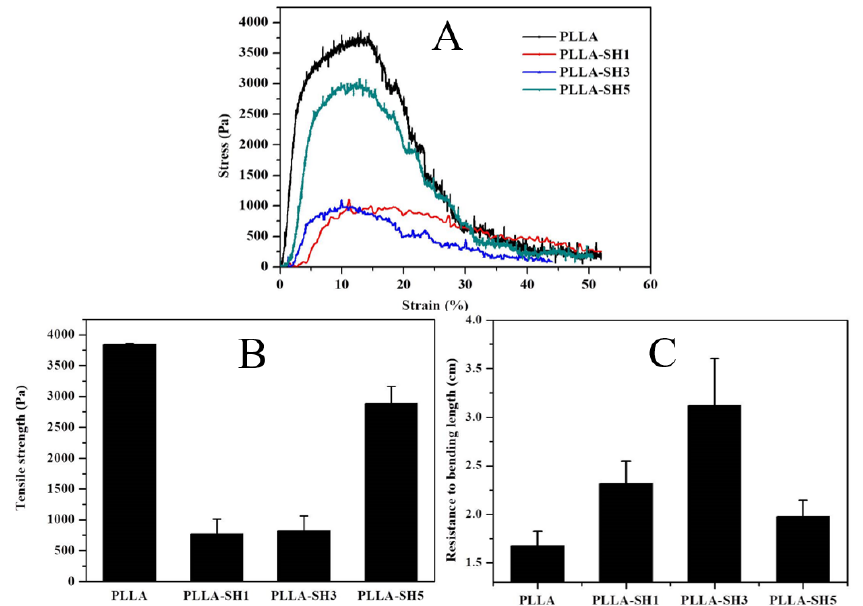
Figure 4. Characteristics of the sericin-modified fiber membranes. ( A ) Tensile stress–strain curves of the fiber membranes. ( B ) Tensile strength of the fiber membranes. ( C ) Fabric bending stiffness of the modified PLLA membrane.